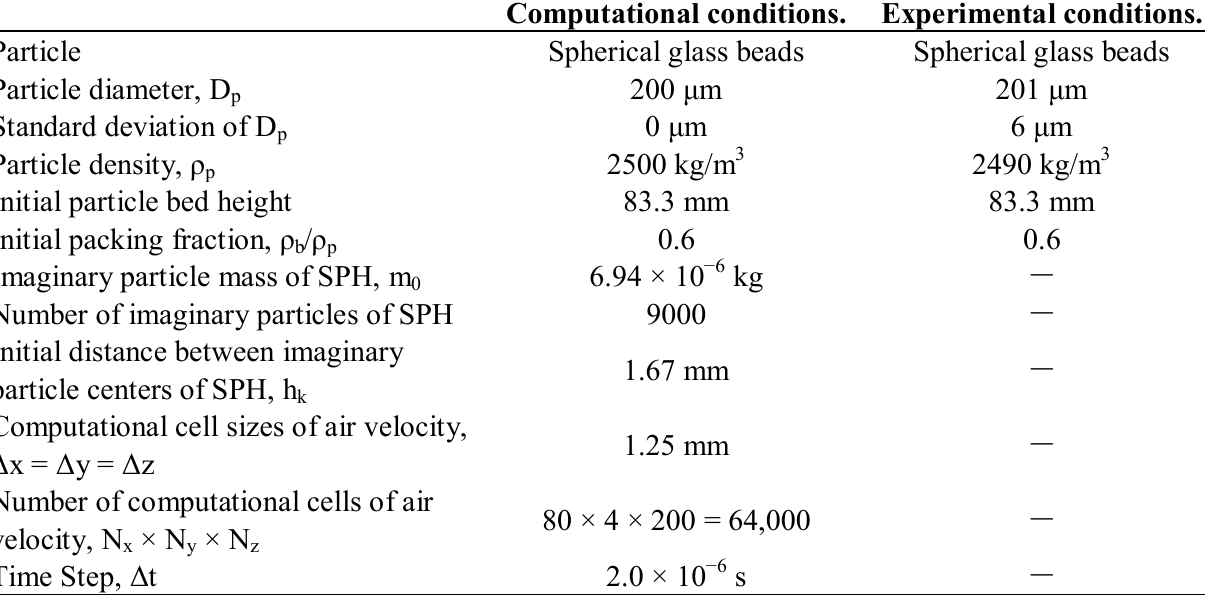
Table 1. Computational and experimental